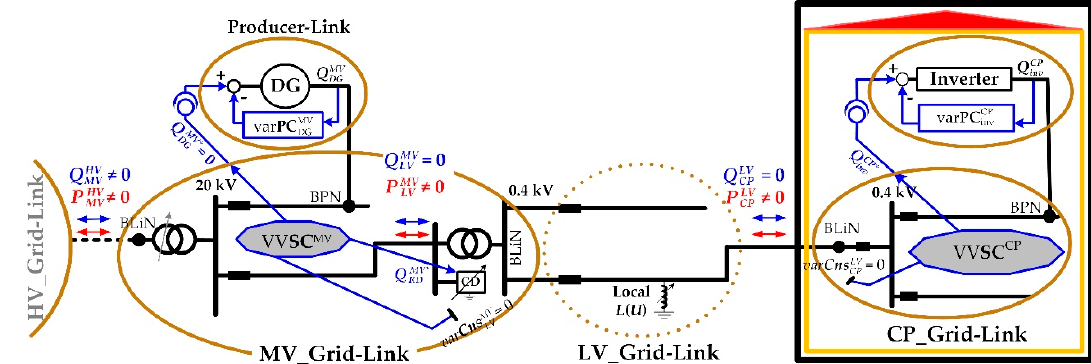
Figure 8. Simplified form of the VVC chain strategy representing the setup with L ( U )-control, CP_ Q -autarky and CDs at the DTRs’ MV-busbars.